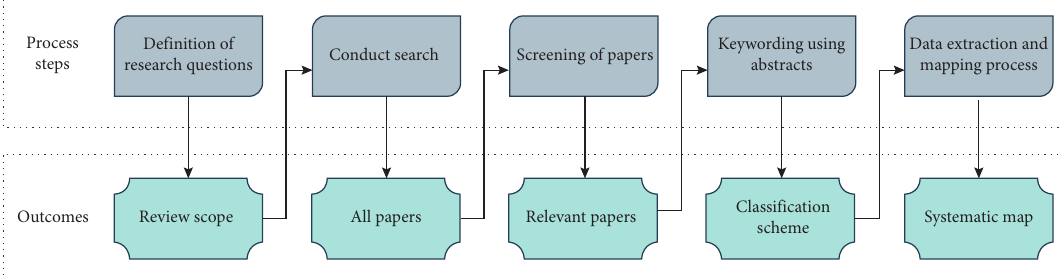
Figure 1: SMS process flow.